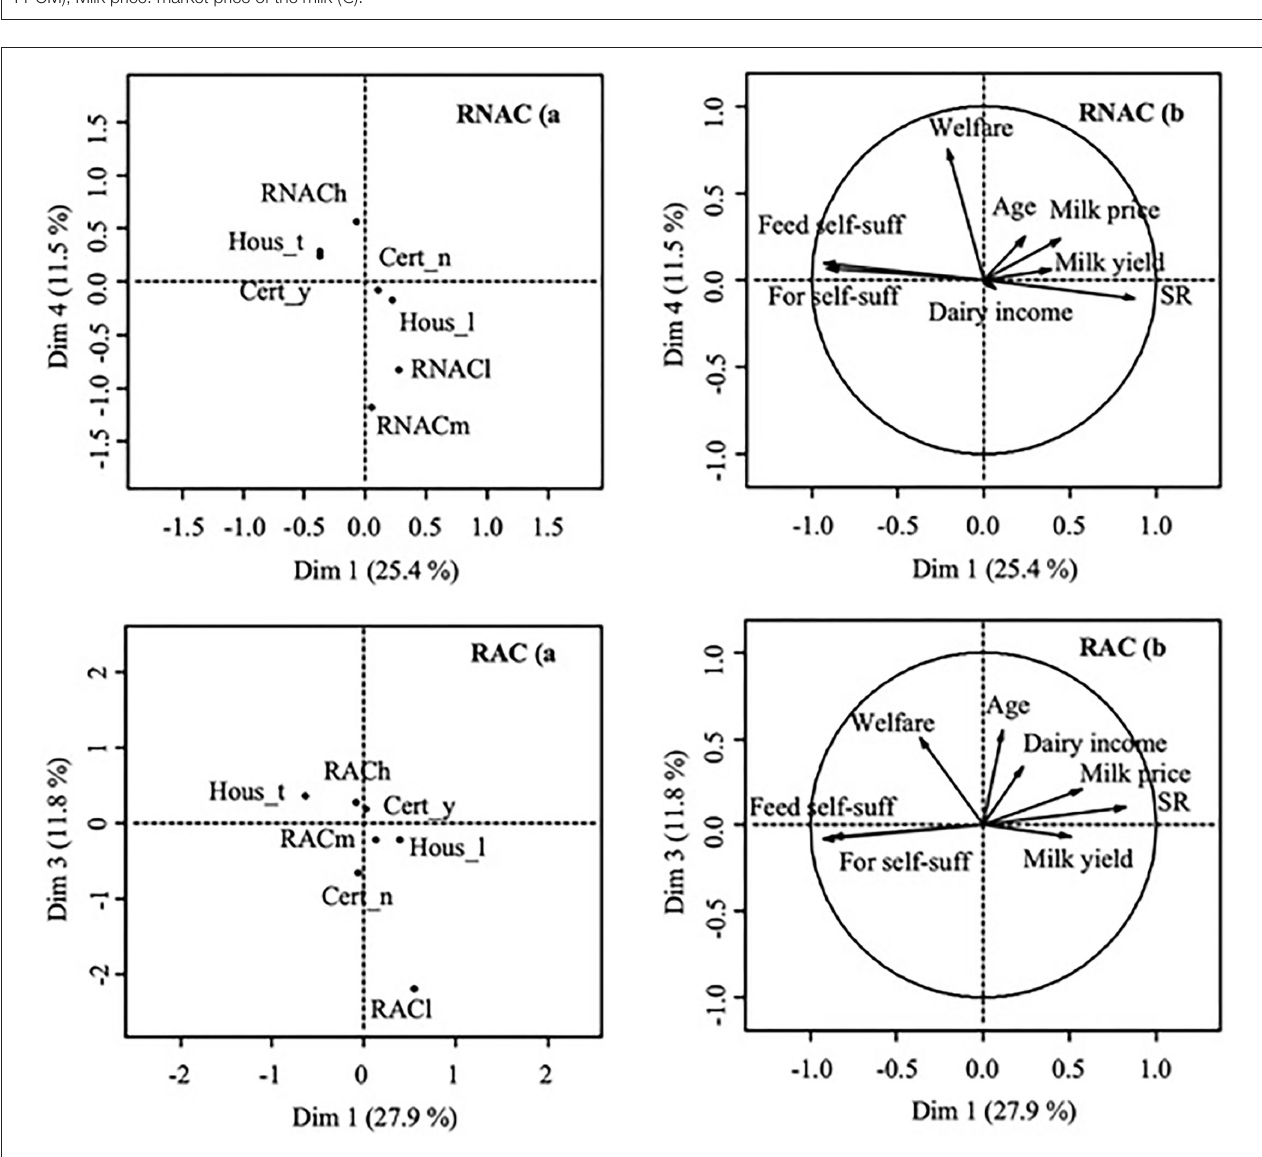
FIGURE 1 | Feed self-suff: feed self-sufficiency of farms (%); For self-suff: forage self-sufficiency of farms (%); Welfare: index of animals welfare (points); Age: age of the farmer (years); Dairy income: farm incomes related to the milk production (%); SR: stocking rate (LU/ha UAA); Milk Yield: milk produced per animal per year (kg FPCM); Milk price: market price of the milk ( e ).